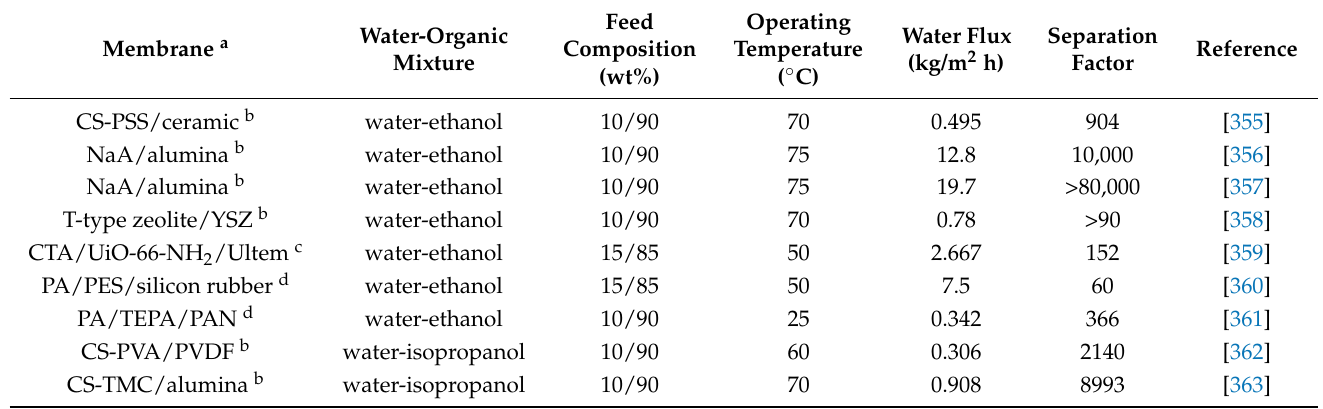
Table 3. Current state-of-the-art hollow fiber membranes for solvent dehydration via